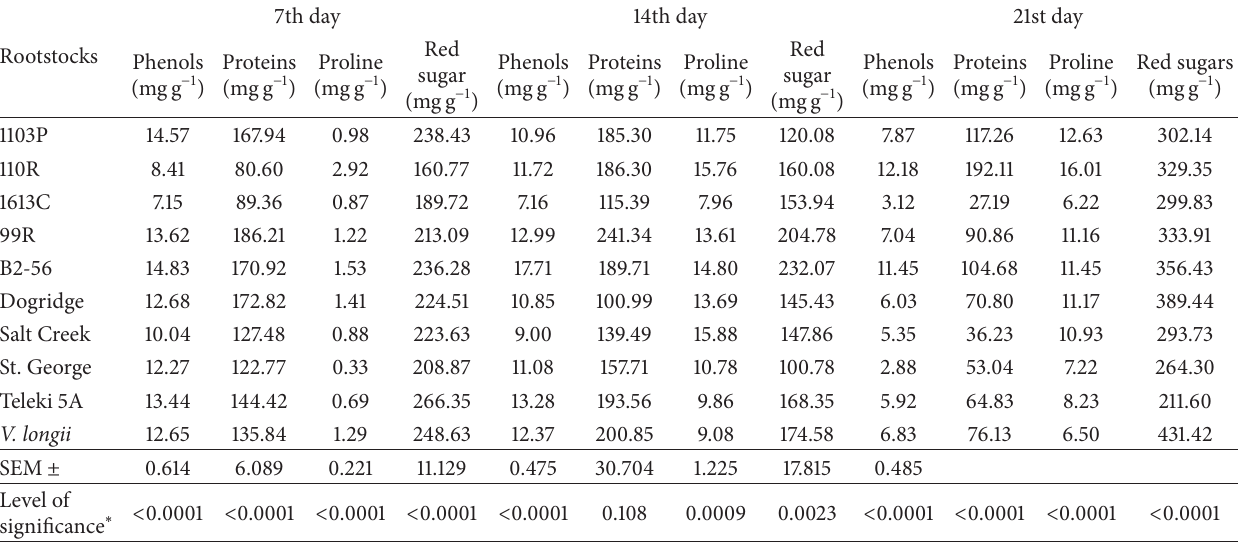
Table 3: Biochemical composition of grape rootstocks at different stages of 50% moisture stress cycle.